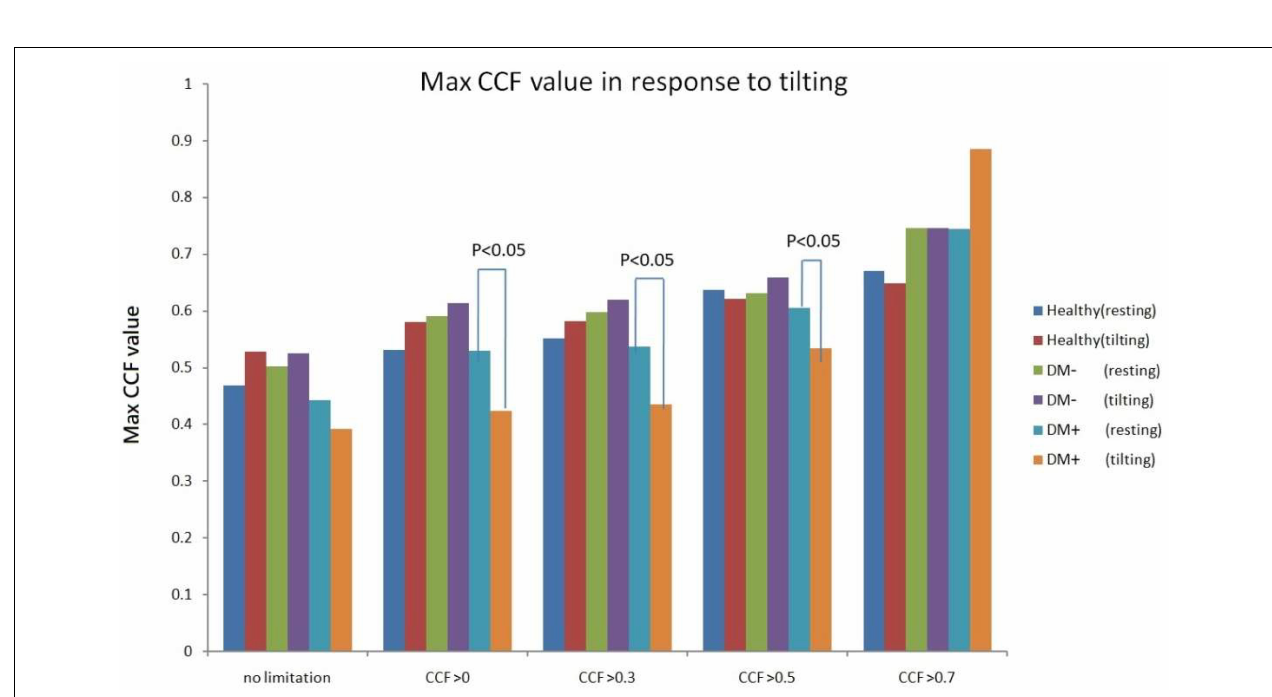
FIGURE 11 | Maximum CCF value response to tilt in healthy (red), diabetes mellitus (DM–, purple), and DM with autonomic neuropathy (DM+, orange) after thresholding of CCF > 0, 0.3, 0.5, and 0.7.